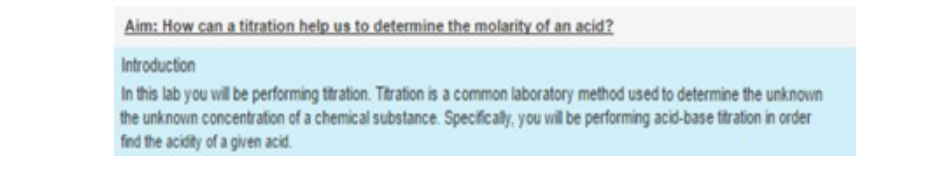
Figure 2. Objective and introduction for the Titration experiment